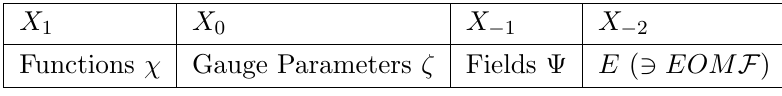
Table 3 . New subspace X 1 required by the failure of